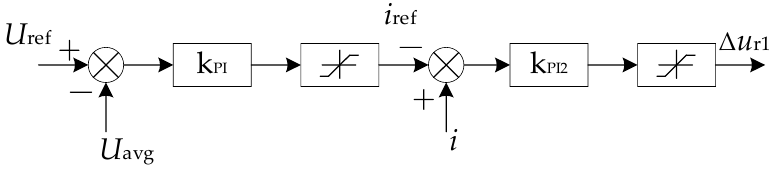
Figure 15. Cluster-group voltage control chart.